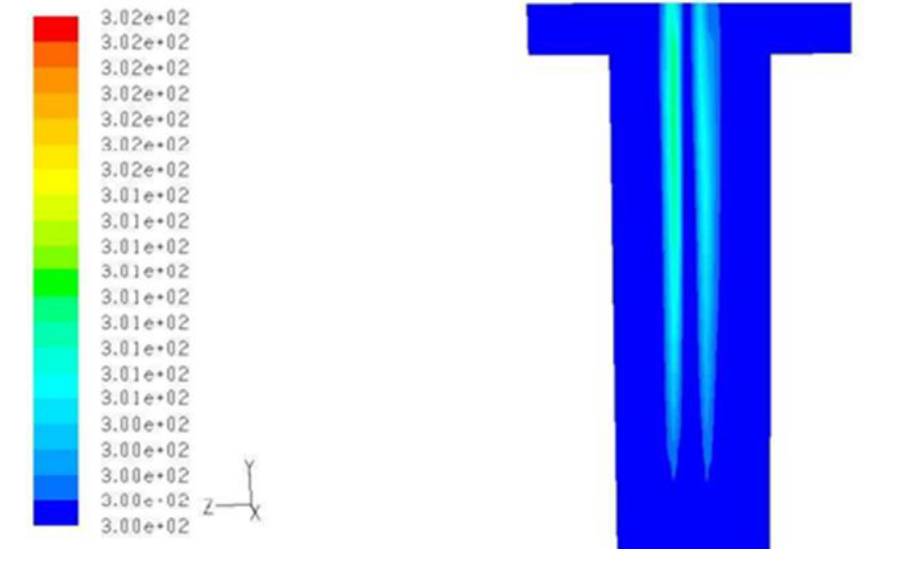
Figure 9. Temperature contour in sub-channel square model.